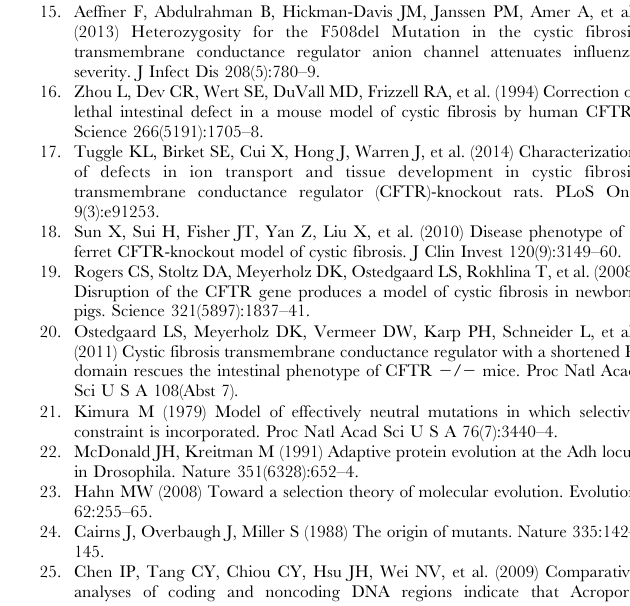
Table S1 SNP incidence in human intronic and exonic DNA. SNPs in 133 human genes known to be lethal or severely debilitating if deleted [90]. Table S2 Synonymous and non-synonymous SNP inci- dence. Exonic SNPs in 98 of the 133 genes shown in Figure 1A, specifically those containing at least one exonic SNP. Table S3 Relationship between human SNPs and vari- able nucleotide positions of non-human species. From among 98 genes described in Figure 2A and Table S2, those with at least 50% concordance among six nonhuman species (rat, mouse, dog, opossum, chicken, frog) were selected for further analysis (22 genes total). The number and type of exonic SNPs in human (from 1000 Genomes) and correspondence with known polymorphic regions in other vertebrate species is